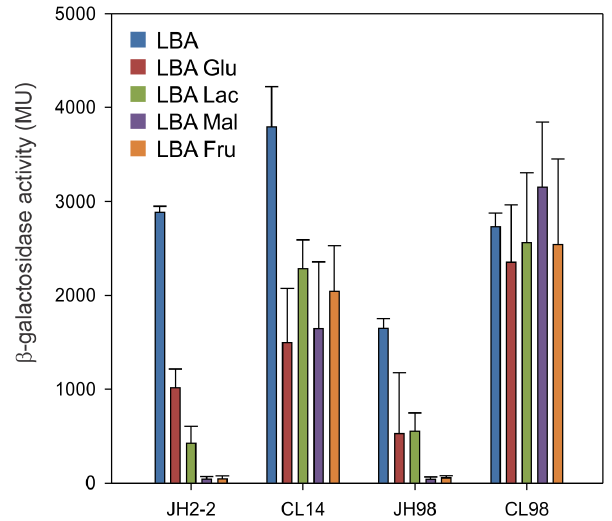
Figure 4. Analysis of CcpA and PTS Man effects on expression of the aguBDAC operon. b -galactosidase activity of P aguB - lacZ tran- scriptional fusion in wild type (JH2-2), ccpA 2 (CL14), mpt 2 (JH98) and ccpA 2 mpt 2 (CL98) strains. Cells were grown in LBA with or without 30 mM glucose (Glu), lactose (Lac), maltose (Mal) or fructose (Fru). Error bars represent standard deviation of at least triplicate